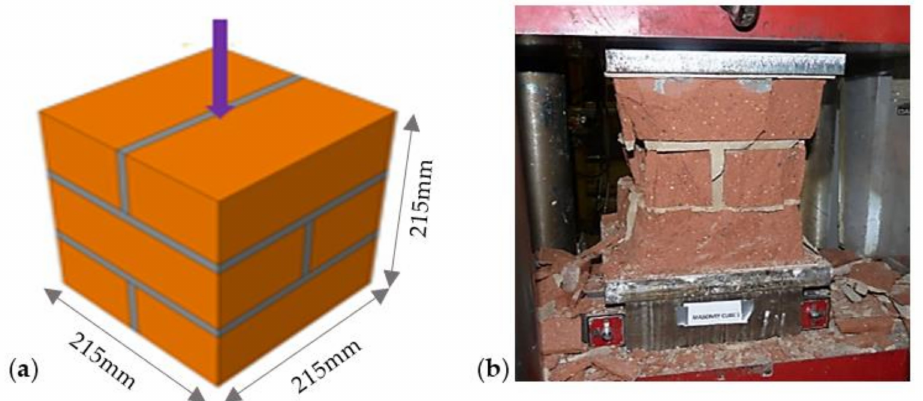
Figure 4. Masonry cubic: ( a ) geometry and ( b )